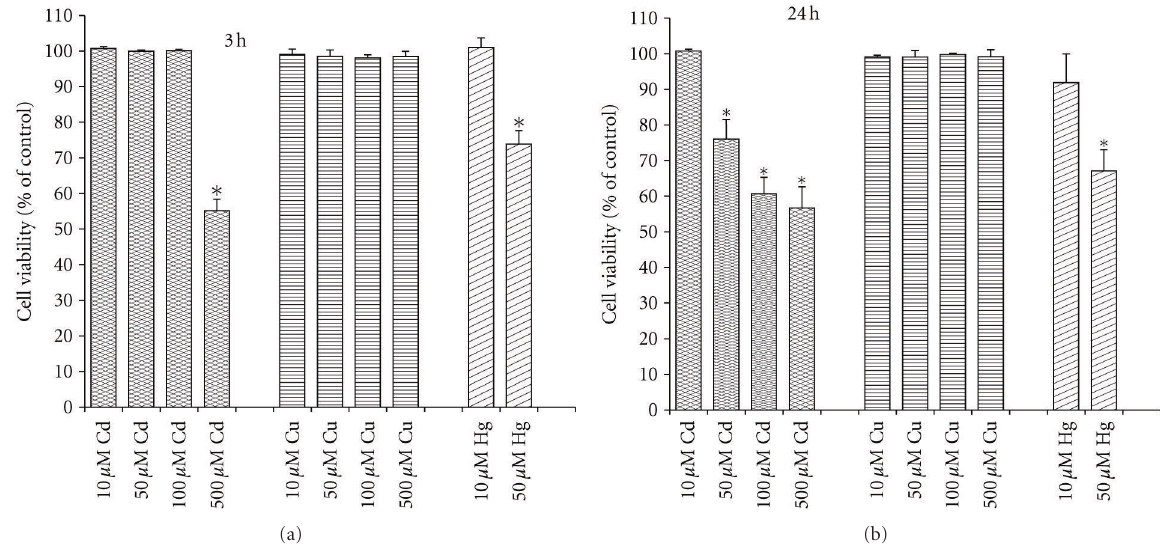
Figure 1: Time- and dose-dependent response to Cd 2+ , Cu 2+ , and Hg 2+ on PC12 cell viability assessed by LDH release. The results are expressed in % to corresponding control ( ∗ P < 0 . 05 compared to untreated control; n = 4–9 independent